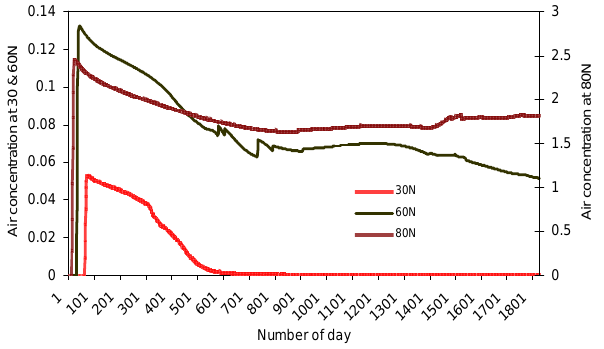
Fig. 5. Daily time series of modeled γ -HCH air concentration at 30 ◦ , 60 ◦ and 80 ◦ N over a 5 years period.